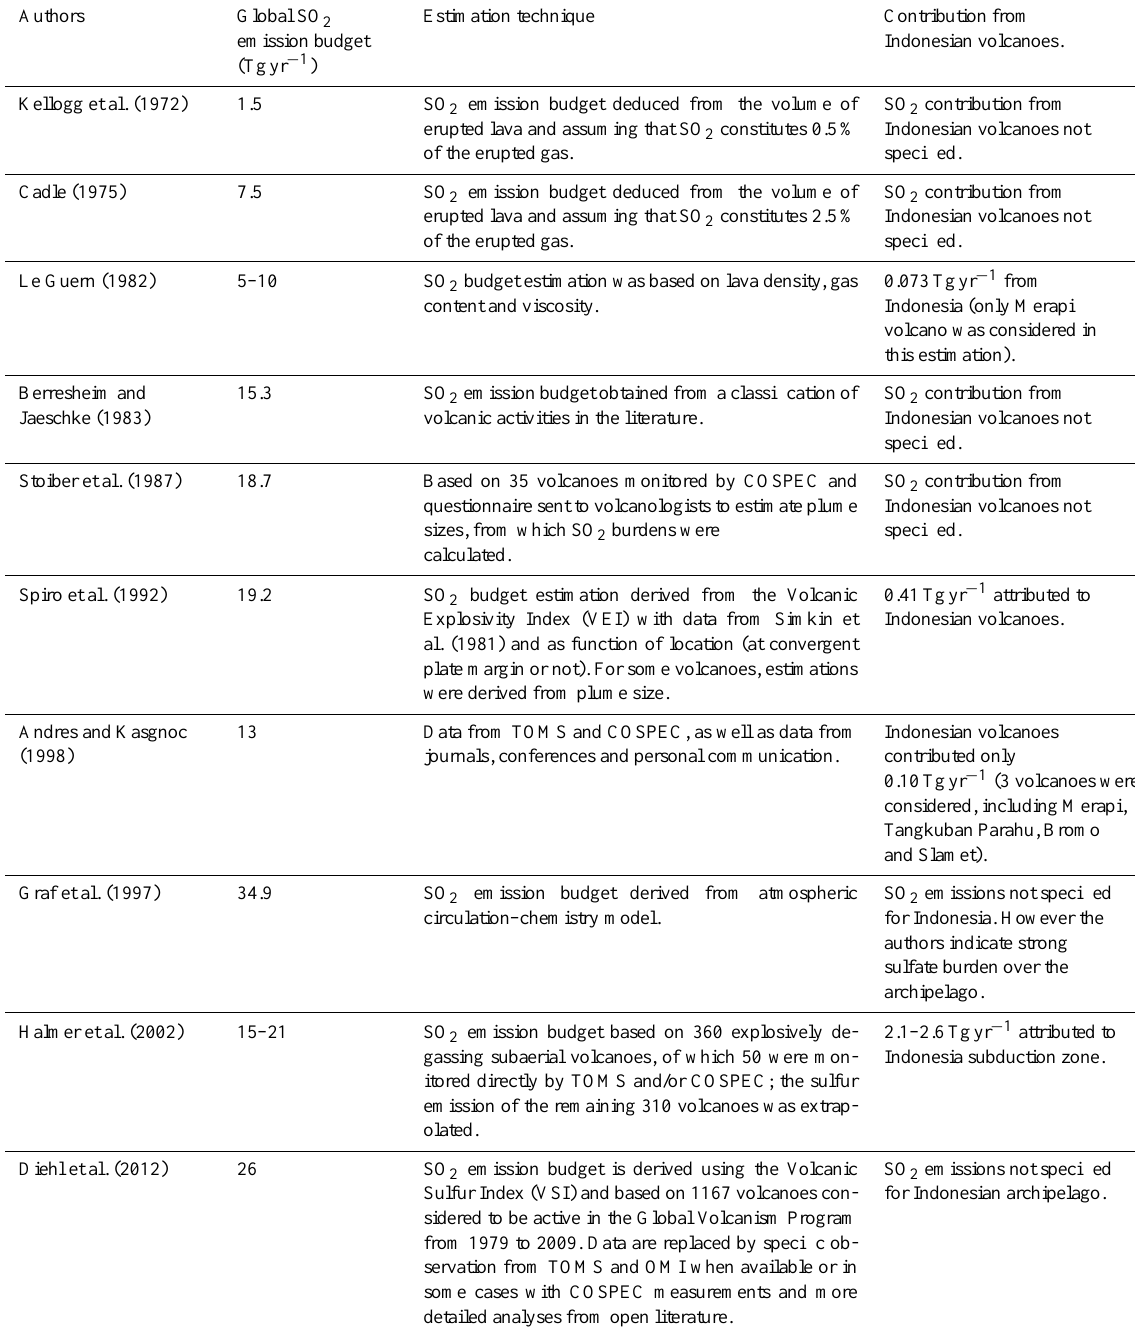
Table 1. SO 2 flux contributions from Indonesian volcanoes in the global volcanic emission